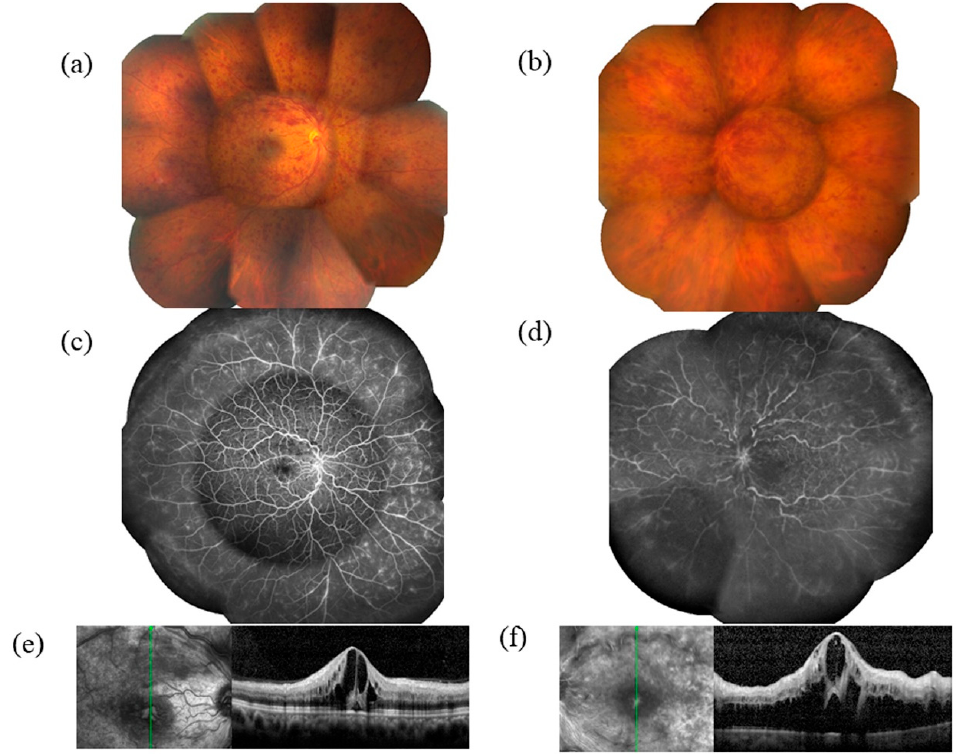
Figure 1. Images of central retinal vein occlusion (CRVO). ( a ) Color fundus photograph of nonischemic CRVO. ( b ) Fluorescein angiogram showing ischemic CRVO. ( c ) Mild retinal hypoxia in a case of nonischemic CRVO. ( d ) Severe retinal hypoxia in a case of ischemic CRVO. ( e , f ) Optical coherence tomography images of macular edema and serous retinal detachment in ( e ) a case of nonischemic CRVO (in which they can occur even if retinal hypoxia is mild) and ( f ) a case of ischemic CRVO (in which they are